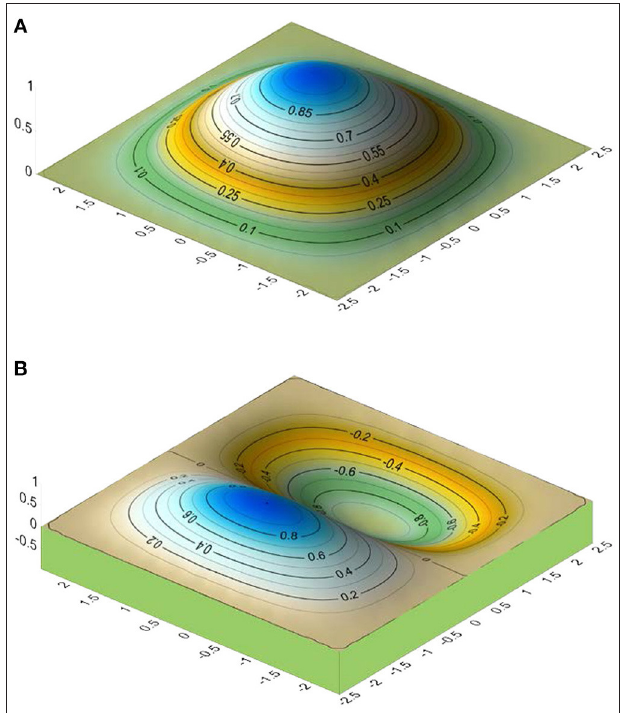
FIGURE 9 | (A) 1st vibration mode of the shell in Example 3-case (b). (B) 2nd vibration mode of the shell in Example 3-case (b).